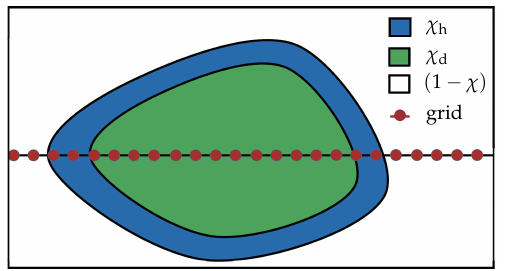
Figure 1. Illustration of different masking functions used for different penalization terms: χ h is the masking function for the hyperbolic thin layer, χ d is for the diffusive internal region, and (1 − χ ) is for the external fluid